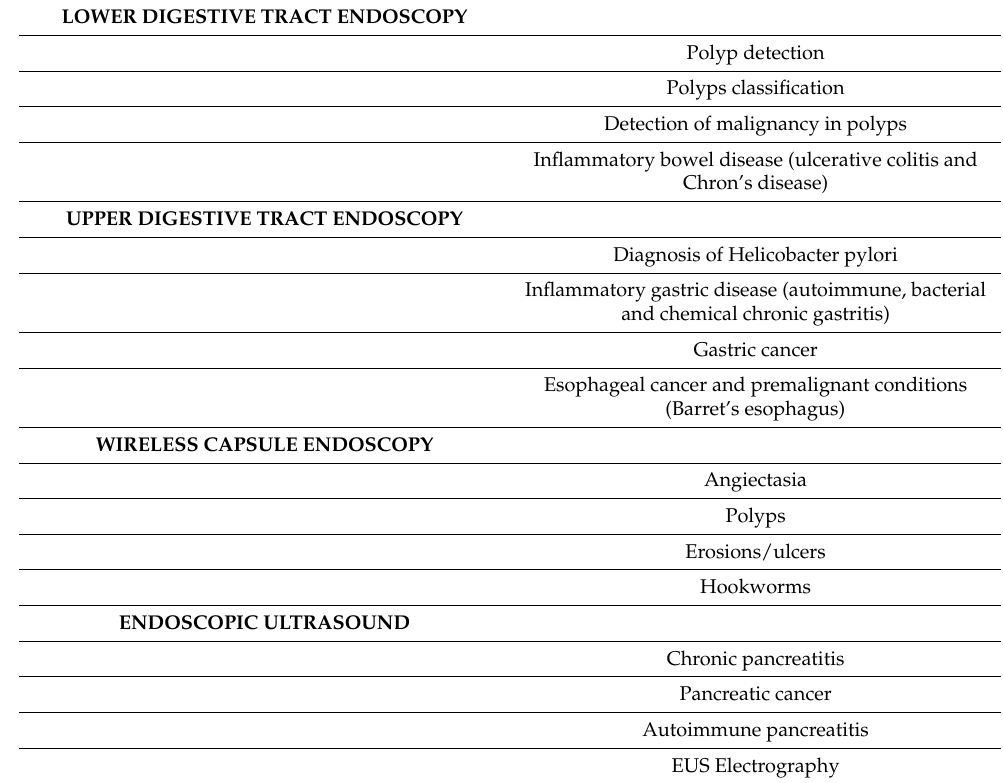
Table 1. Applications of CAD and AI in endoscopic